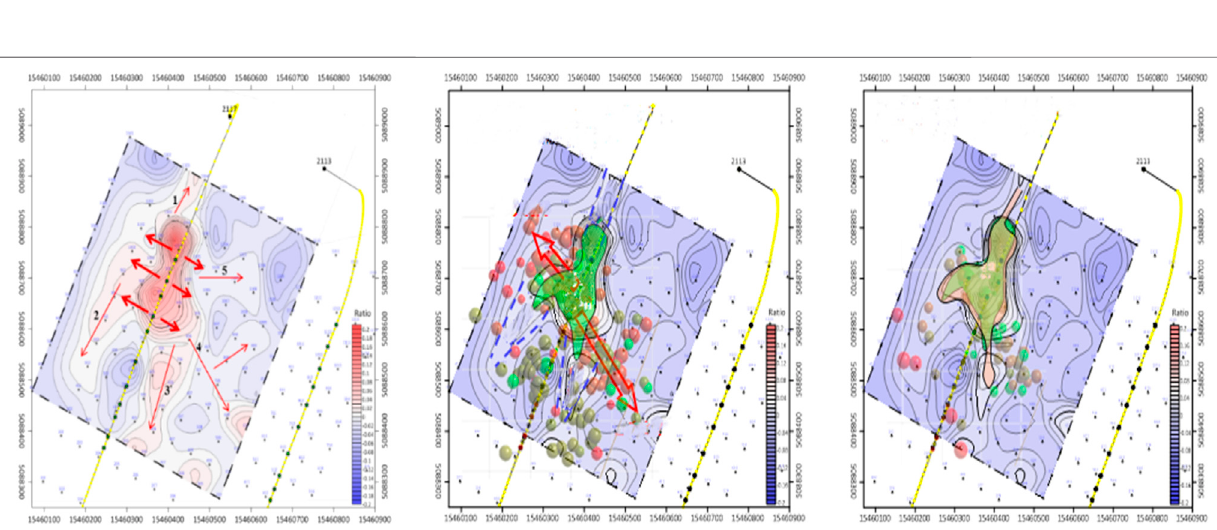
Frontiers in Earth Science |